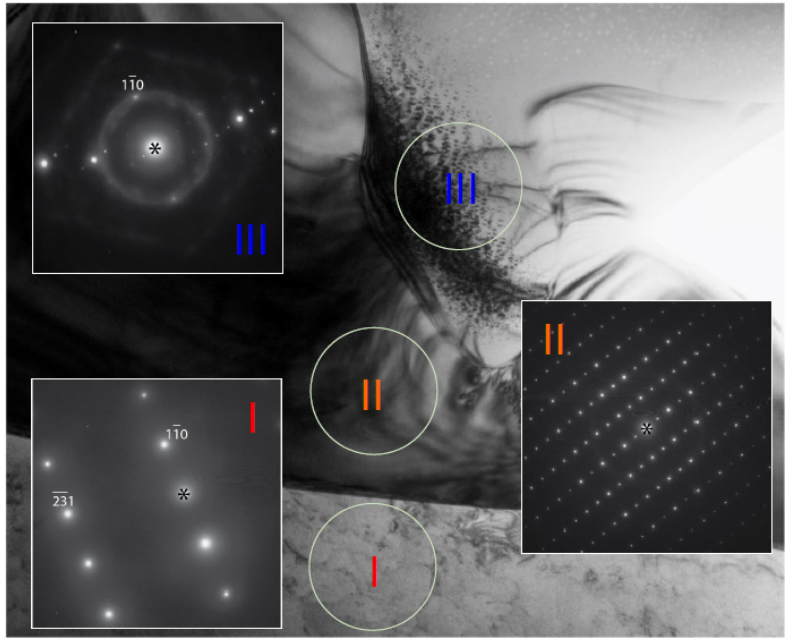
Figure 7. Selected area electron diffraction (SAED) patterns from Phases I–III in Alloy P7. Batteries 2016 , 2 , 22 Table 3. EDS results (in at%) from selective spots in Figure 6a. B / A is the ratio between the sum of at% from other elements vs. Ti and Zr (bcc and C14) and Ti, Zr, and V (B2). Area